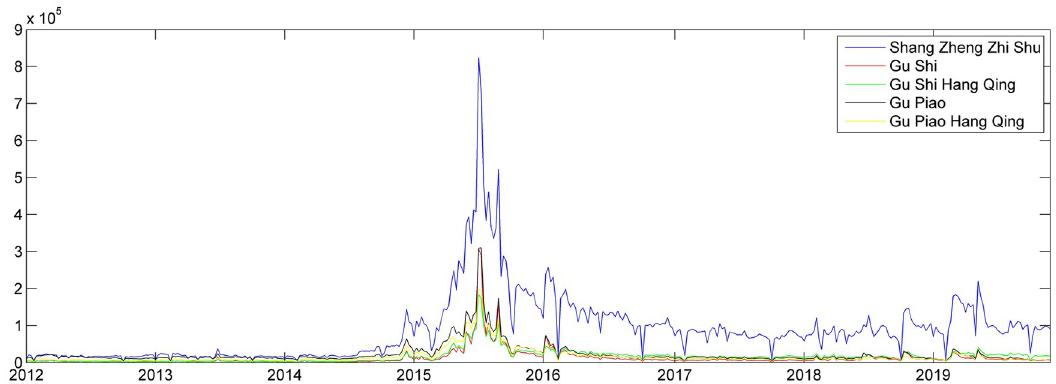
Fig 2. Search volume index of the potential keywords (from April 1st, 2012 to November 30 th , 2019) a . a The data was downloaded from